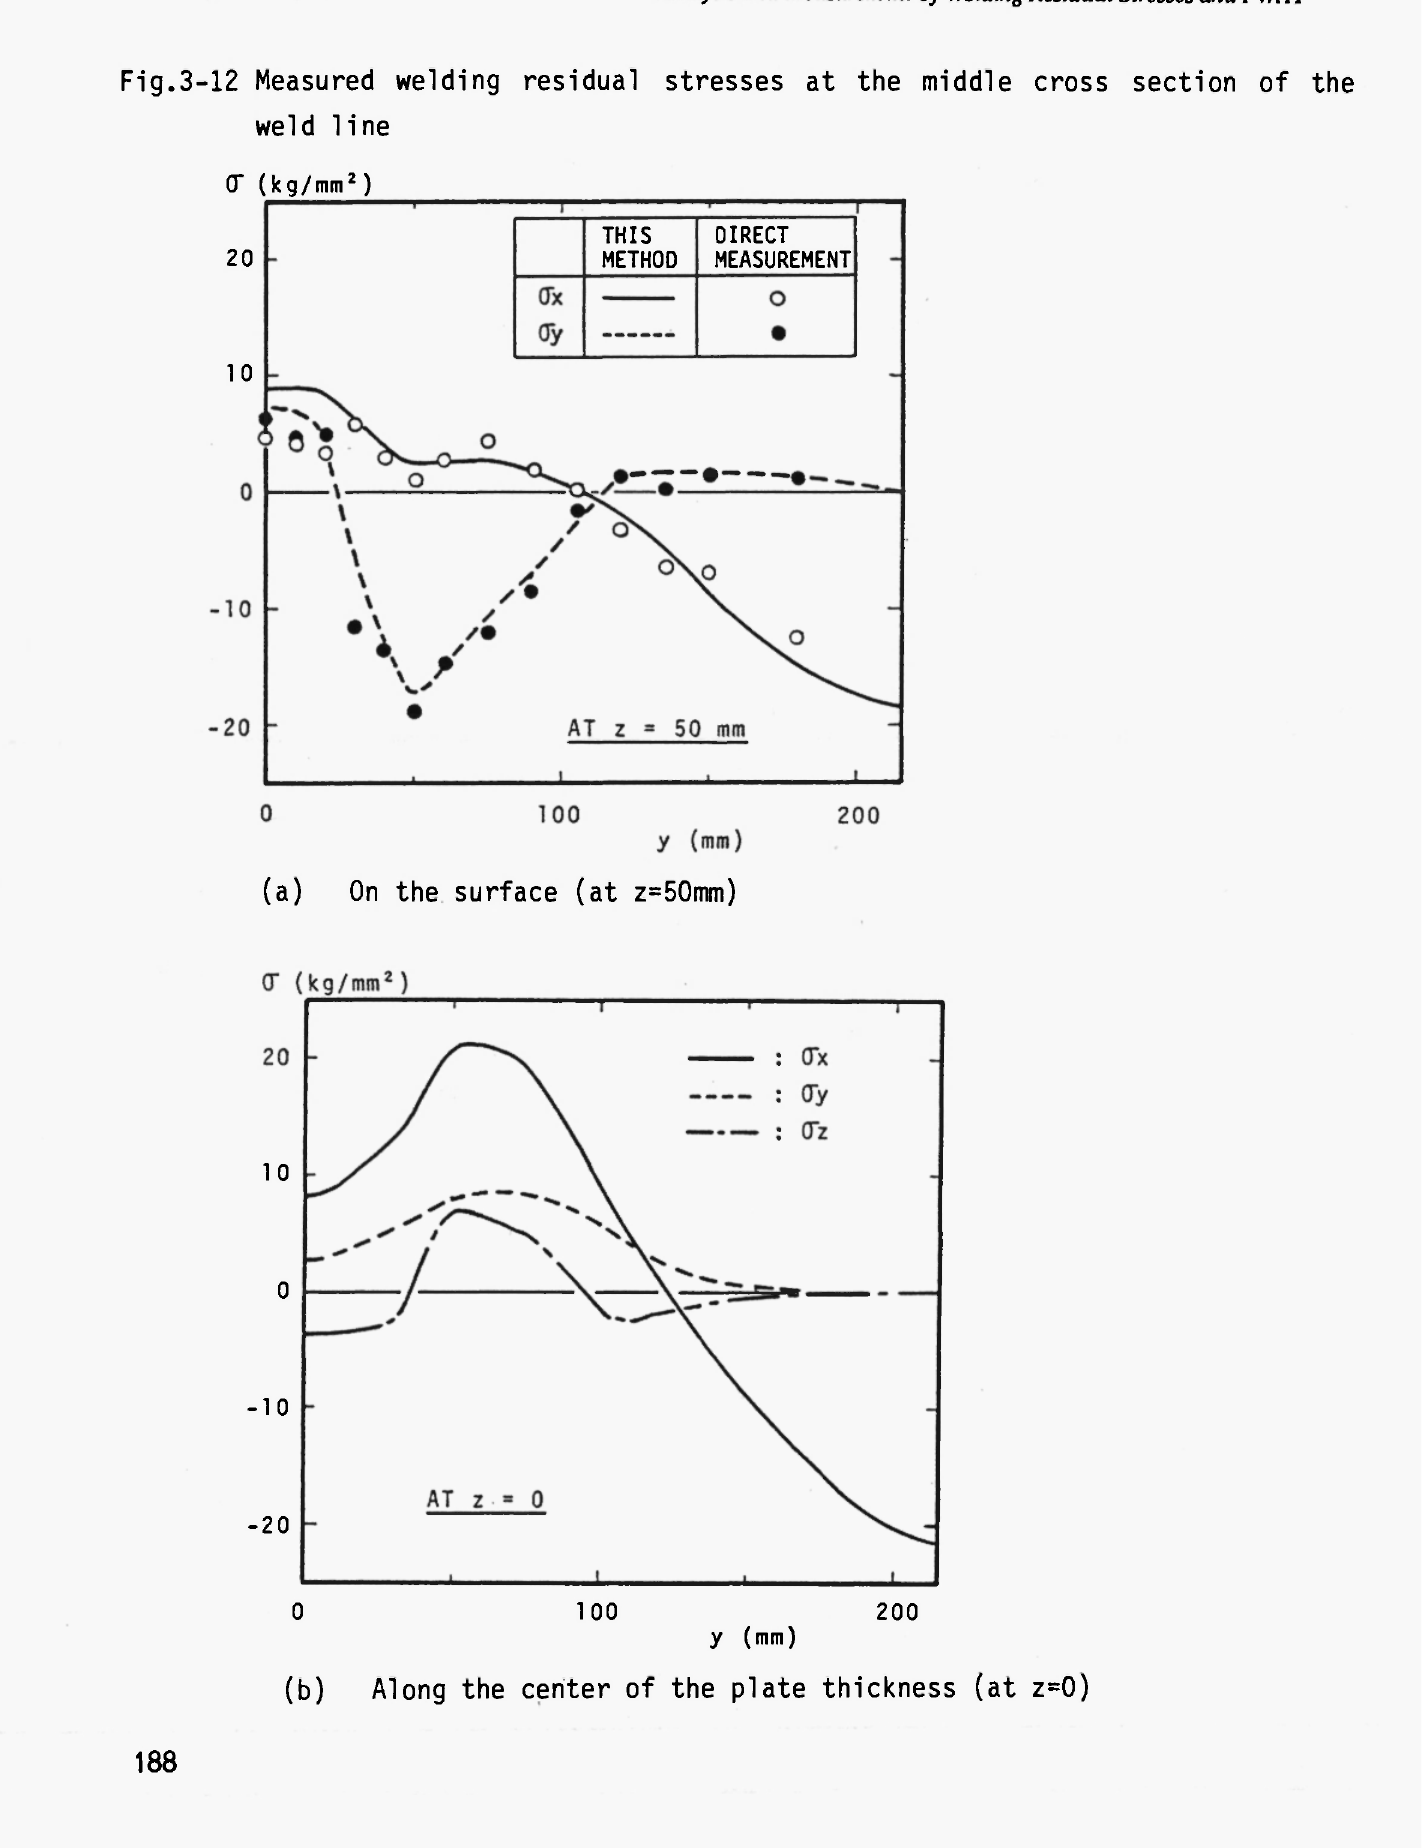
Fig.3-12 Measured welding residual stresses at the middle cross section of the weld line